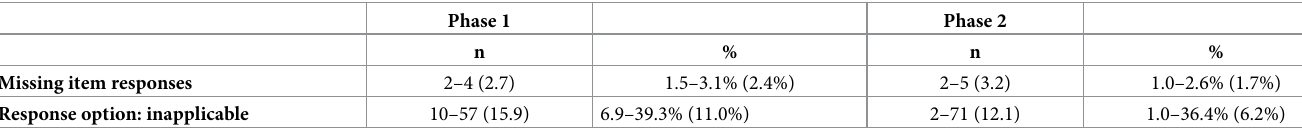
Table 2. Mean (range) missing item responses of the HINQ-62 in phase 1 and